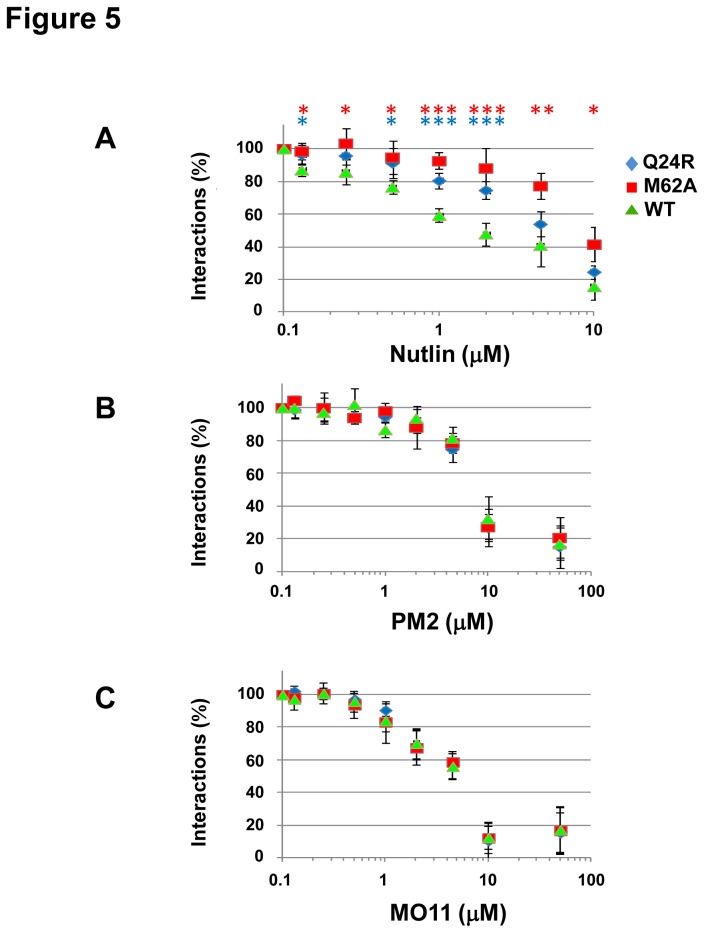
Direct interaction between p53 and HDM2 N-terminal domain inhibited by stapled peptides.F2H assay to investigate the interaction of p53 (bait) with wild-type HDM2 (WT), mutant Q24R and M62A (preys). The F2H assay measures the interaction between two proteins as ratio of cells showing co-localization of bait and prey at the nuclear F2H interaction platform, to cells not showing this co-localization. A. Titration of Nutlin results in increased dissociation of WT-p53 complex compared to Q24R/M62A-p53 complexes. B-C, In contrast, the stapled peptides display equivalent potency on WT and mutant HDM2. Data points represent normalized interaction values expressed as percentage interactions observed in the absence of treatment ± SD (n=4). * p < 0.05, ** p < 0.01, *** p < 0.005 (WT vs M62A, blue asterisks. WT vs Q24R, red asterisks).